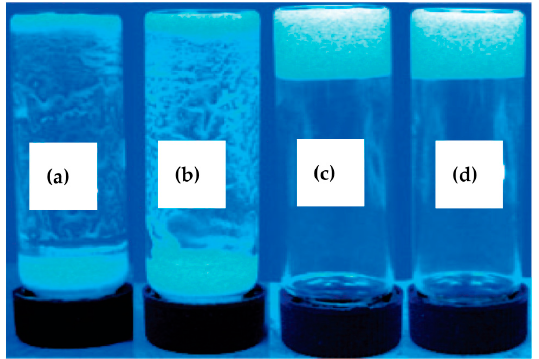
Figure 2. Optical photos of the complexes of: ( A ) mPEG1.1K; and ( B ) mPEG2K with α -CD; and invertible supramolecular hydrogels formed by: ( C ) Ada-PEG1.1K; and ( D ) Ada-PEG2K and α -CD. Reproduced from [65] with permission. Copyright 2008 American Chemical Society.